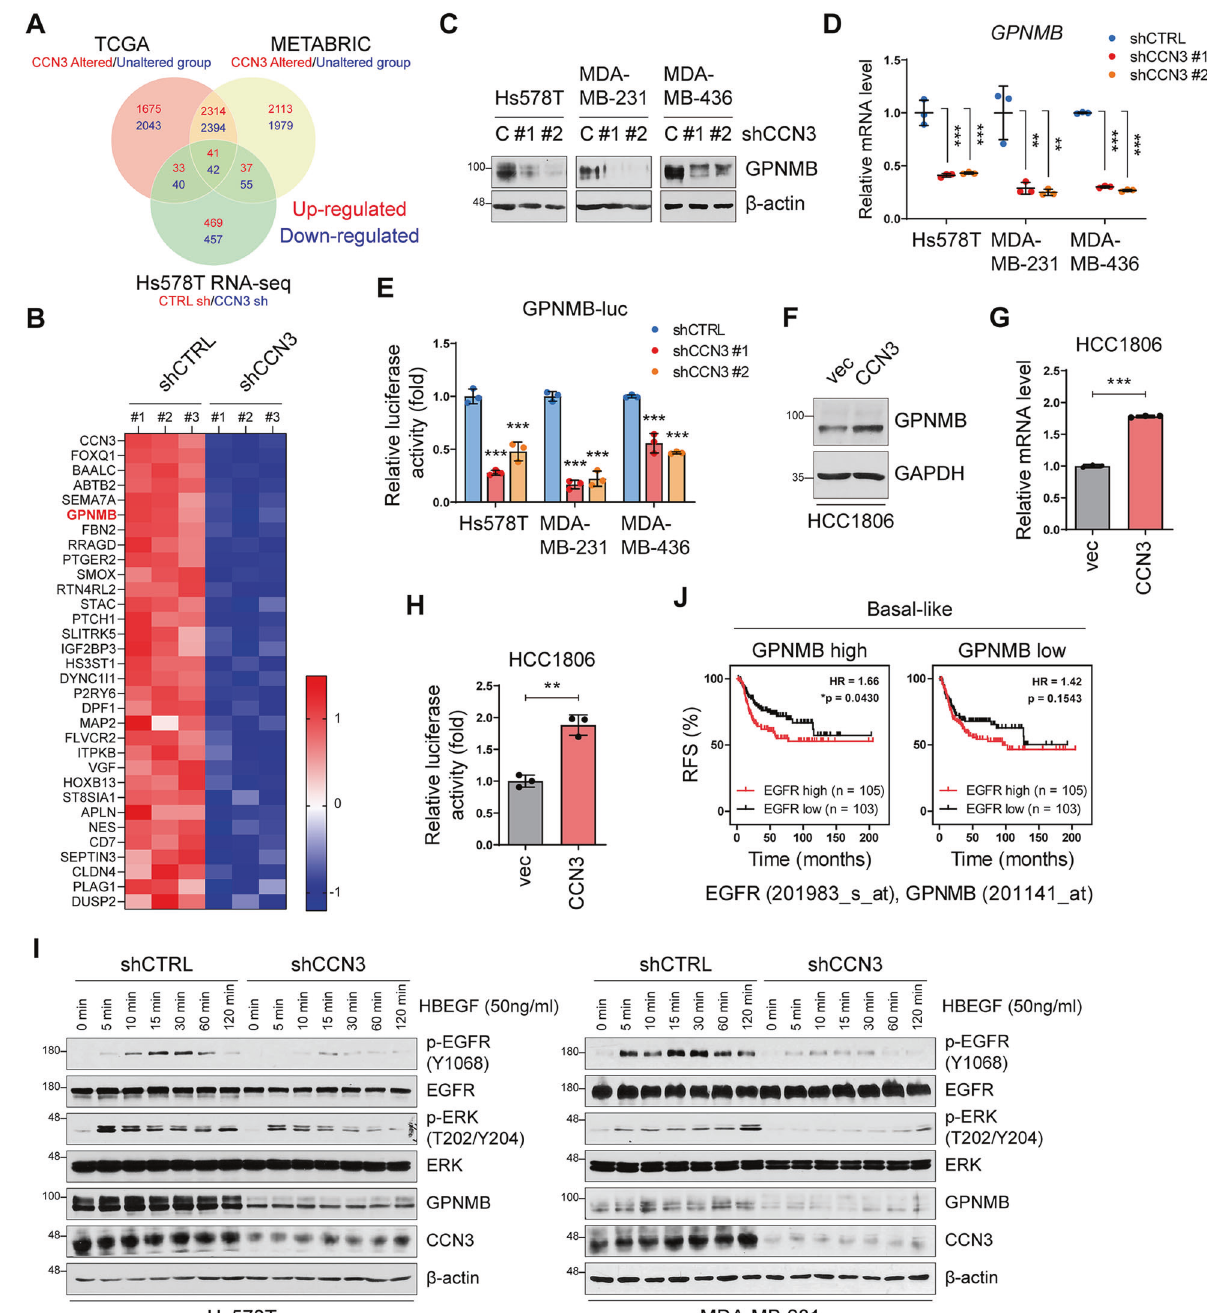
Fig. 6 CCN3 regulates GPNMB expression. A The Venn diagrams represent the number of genes up- or down-regulated by CCN3 expression in each dataset. B The heatmap presents up-regulated genes by CCN3 from an RNA-seq dataset (< 2-fold, p < 0.0001). Up-regulated genes were common genes from Venn diagram ( A ). C Western blot analysis of whole cell lysate of CCN3 knockdown cell lines with indicated antibody. β -actin was used as a loading control. D RT-qPCR analysis showed the GPNMB mRNA level in Hs578T, MDA-MB-231 and MDA-MB- 436 CCN3 knockdown cell lines. Each value was normalized with GAPDH. Mean ± SD ( n = 3). P -values were calculated with one-way ANOVA with a post-hoc Dunnett ’ s multiple comparison test (** p < 0.005, *** p < 0.0005). E A dual luciferase assay was performed using pGL3-GPNMB- luc construct. pCMV-RL was used as an internal control. Mean ± SD ( n = 3). P -values were calculated with one-way ANOVA with a post-hoc Dunnett ’ s multiple comparison test (*** p < 0.0005). F Western blot analysis of CCN3 overexpression cell lines with indicated antibodies. GAPDH was used as a loading control. G RT-qPCR analysis showed GPNMB mRNA level in HCC1806 CCN3 overexpression cell lines. Each value was normalized with GAPDH. Mean ± SD ( n = 3). P -values of CCN3 overexpression cell lines were calculated with two-tailed student t -test. (*** p < 0.0005). H Dual luciferase assay was performed using pGL3-GPNMB-luc construct. pCMV-RL was used as an internal control. Mean ± SD ( n = 3). P -values of CCN3 overexpression cell lines were calculated with two-tailed student t -test. (** p < 0.005). I Western blot analysis of whole cell lysate of CCN3 knockdown cell lines with indicated antibody. Each cell line treated with HBEGF (50 ng/ml) at the indicated time points. β -actin was used as a loading control. J Recurrence-free survival plot of patients with EGFR high versus low expression with basal-like breast cancer patients. Each panel indicated patients fi ltered by median expression of GPNMB . P -values were calculated with log-rank test.